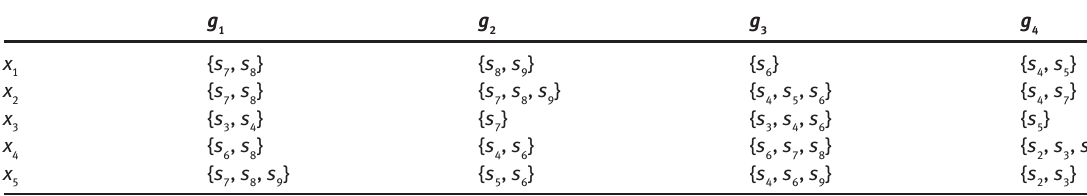
Table 1: Decision Matrix H (1) .